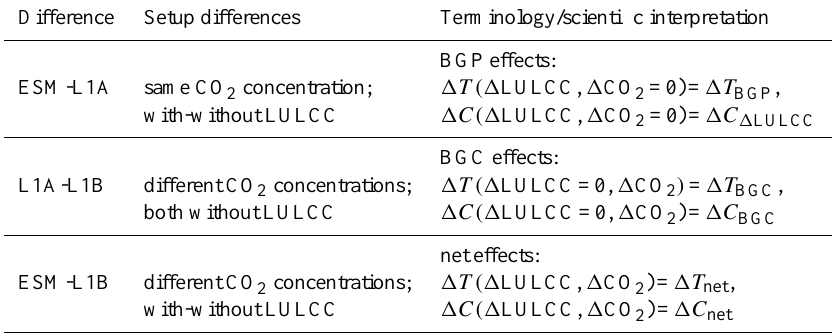
Table 2. Overview of model setups and analysis strategies.